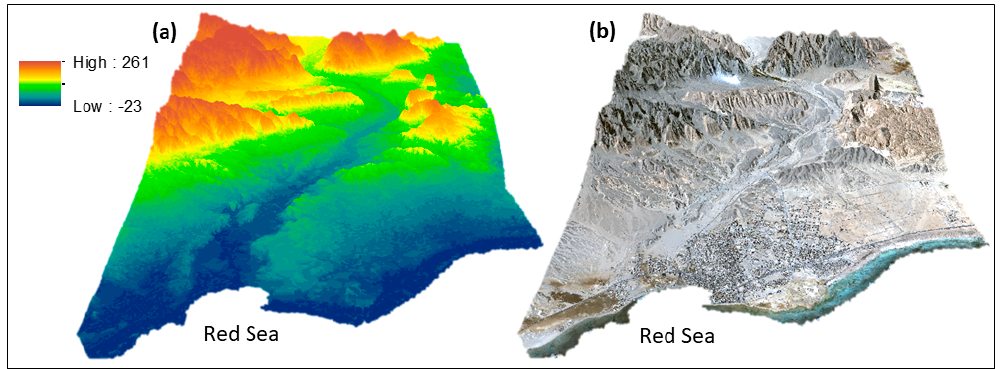
Figure 6. An oblique, three-dimensional (3D) perspective of the downstream area of Wadi El-Ambagi. ( a ) WorldView-2 (WV-2) stereo pair derived digital elevation model (DEM) and ( b ) WV-2 multispectral imagery superimposed on the 2-m DEM.